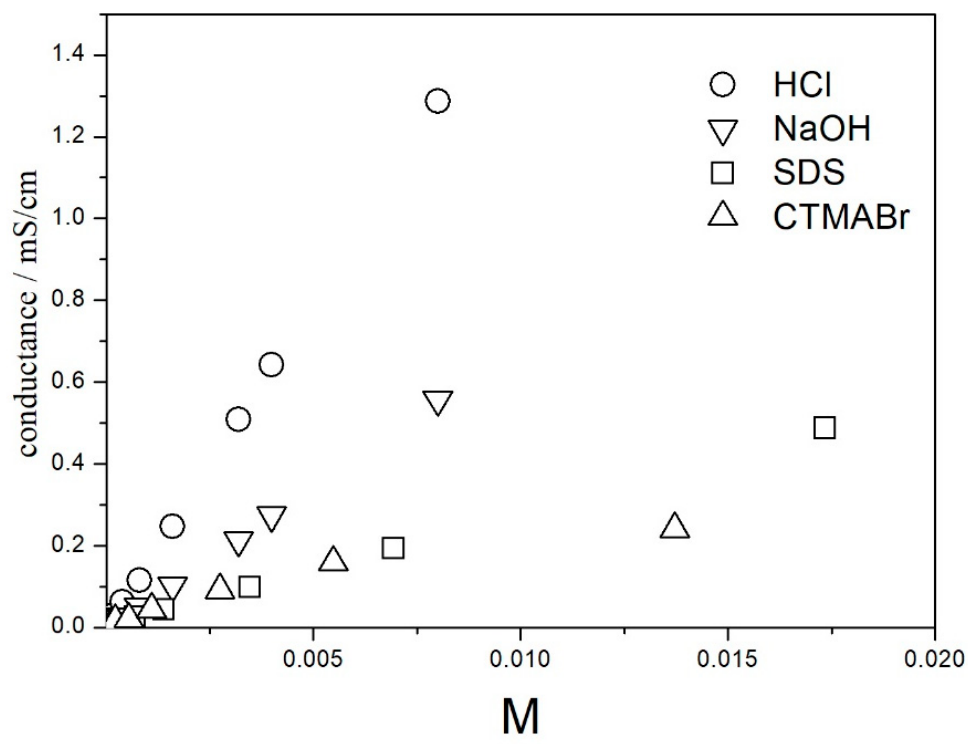
Figure 1. The effect of electrolytes on the conductance of titania dispersion in 50% EG.